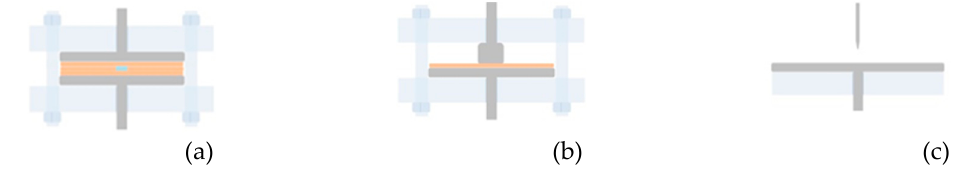
Figure 9. Specimens under testing, simulating ( a ) internal, ( b ) surface, and ( c ) corona defects.